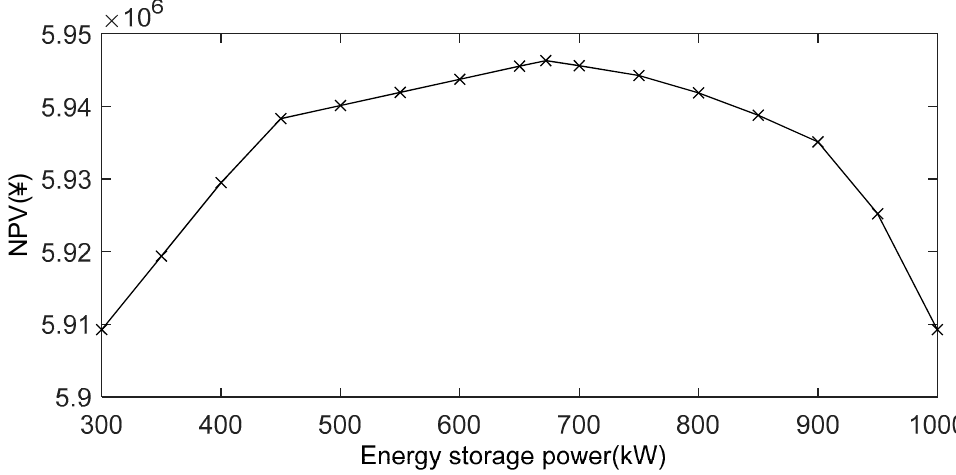
Figure 4. VRLA energy storage power economic evaluation results.